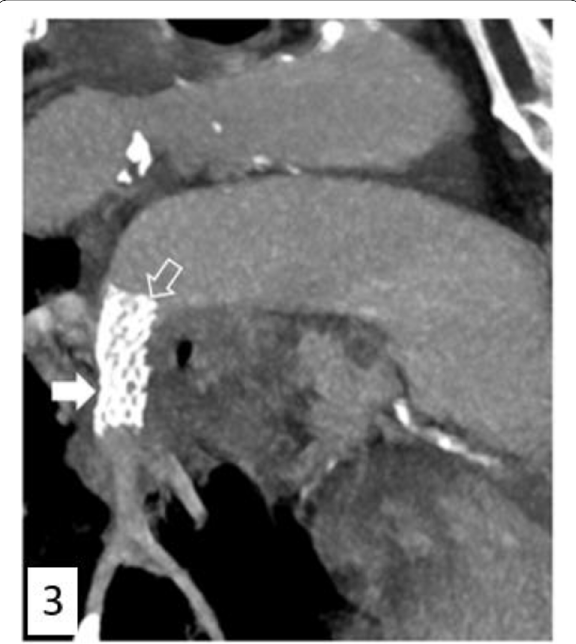
Fig. 3 Postoperative computed tomography angiography after stent deployment ( empty arrow ) placement shows the exclusion of the pseudoaneurysm and the patency of downstream arteries. Sagittal MIP 10 mm reconstruction 80 keV 130 mAs Somatom X.Cite